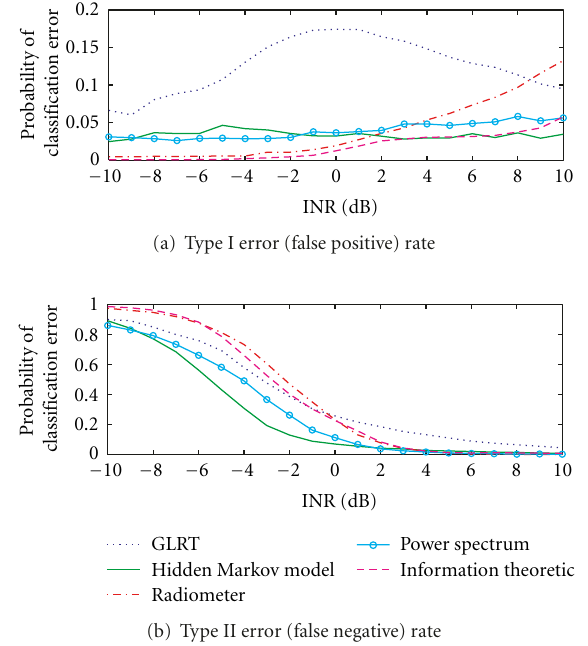
Figure 8: Detection performance, showing the probability of classification error per frequency bin averaged over 1000 trials for an N = 100 length sample vector. One standardized interferer occupying 20% of the receiver input bandwidth was used for all simulations. For each method, the observed probability of type I errors is shown in (a) and the observed probability of type II errors is shown in (b). The legend in (b) applies to both subfigures.